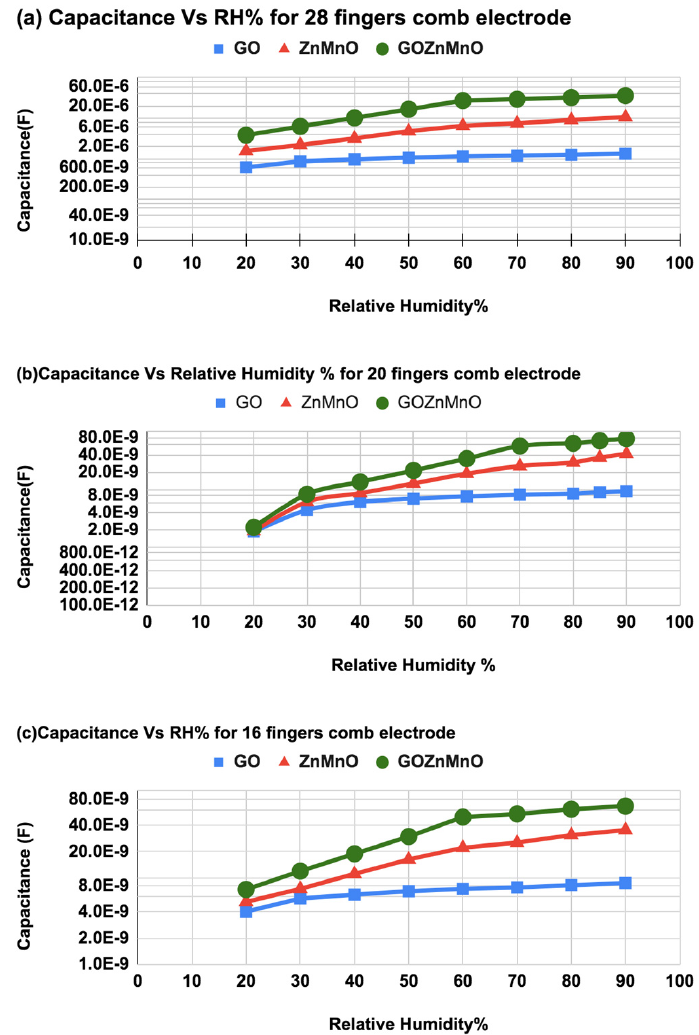
Figure 7. GO-Mn x Zn 1 − x O, Mn x Zn 1 − x O and GO for ( a ) capacitance vs. RH% for 28-finger comb electrode, ( b ) capacitance vs. RH% for 20-finger comb electrode, ( c ) capacitance vs. RH% for 16-finger comb electrode.